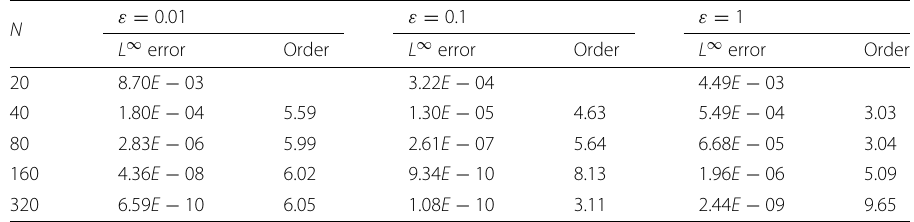
Table 5 Example 1. L ∞ errors and numerical orders of spatial accuracy obtained with the GSA IMEX-ARS3 WCNS at t = 0.05